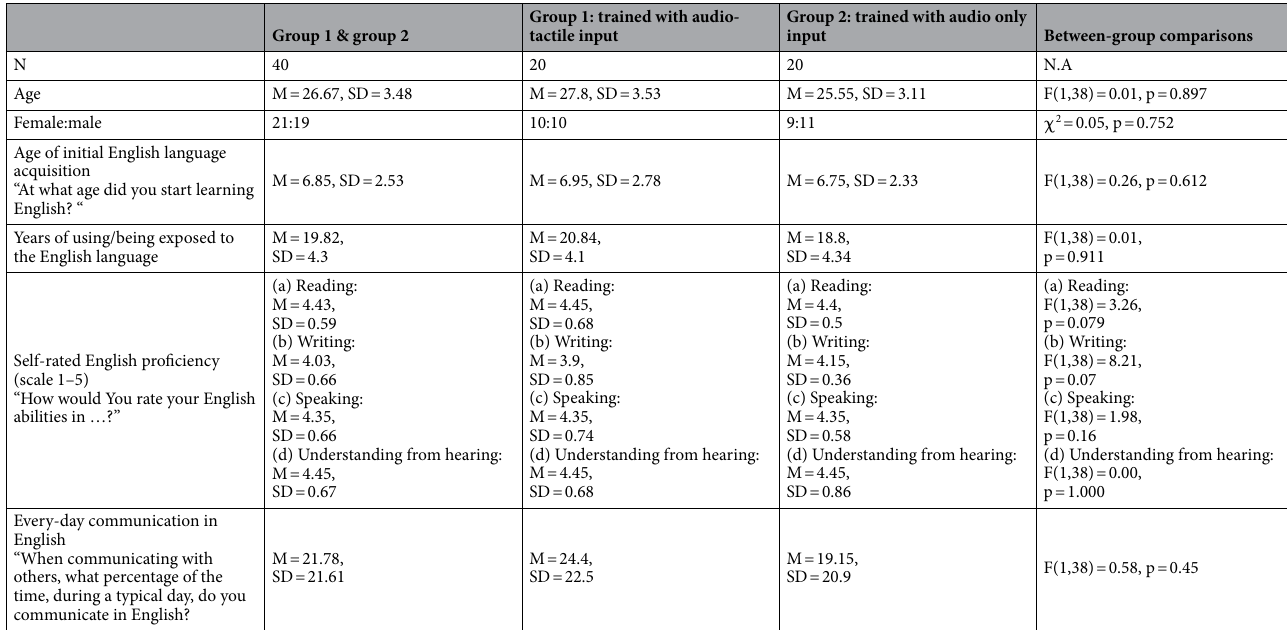
Table 1. Group composition and the English language